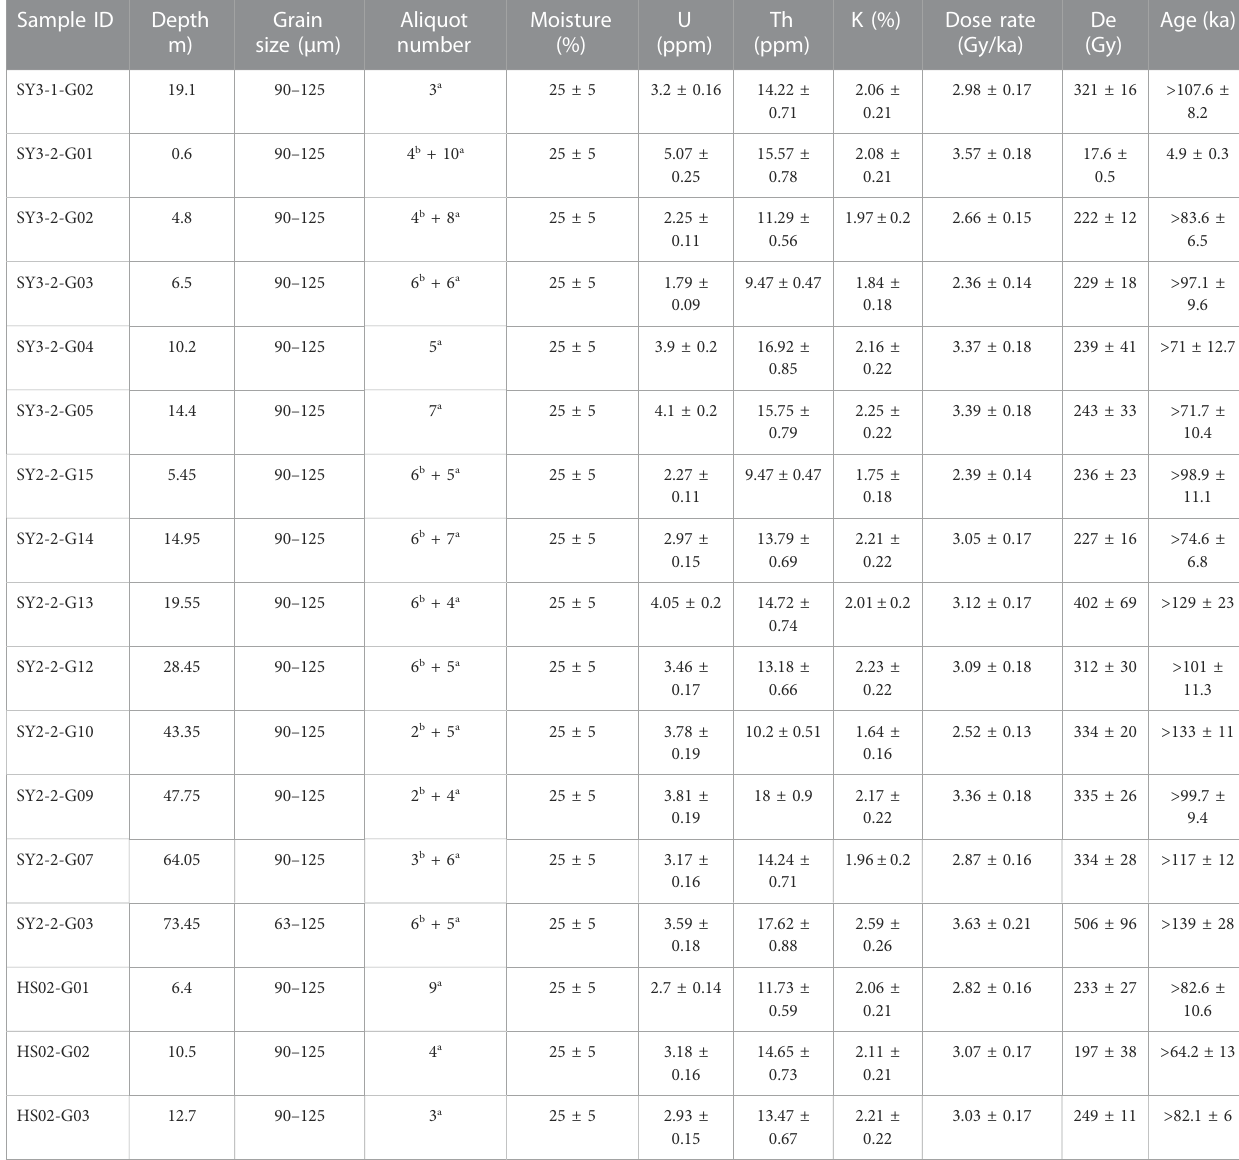
TABLE 1 OSL dating results from cores SY3-1, SY3-2, SY2-2, and HS02, in the neritic area of the Lianjiang River plain. Sample